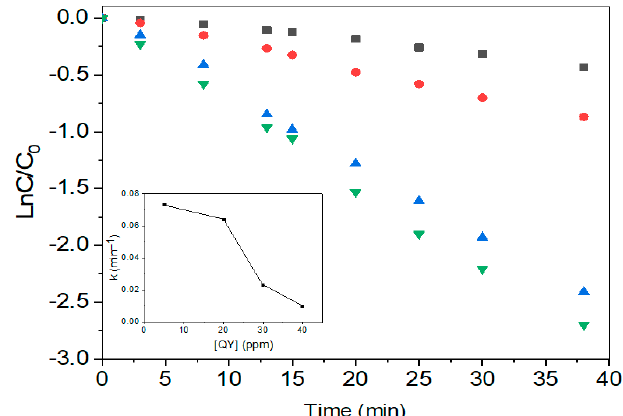
Figure 7. Effect of pH on the photocatalytic performance of Ag 3 PO 4 , ▲ : pH = 4,  : pH = 6, ▼ : pH = 7,  : pH = 8,  : pH = 11. Insert: Rate constants vs. pH ([QY] 0 = 20 ppm and Ag 3 PO 4 dose = 0.5 g·L − 1 ).